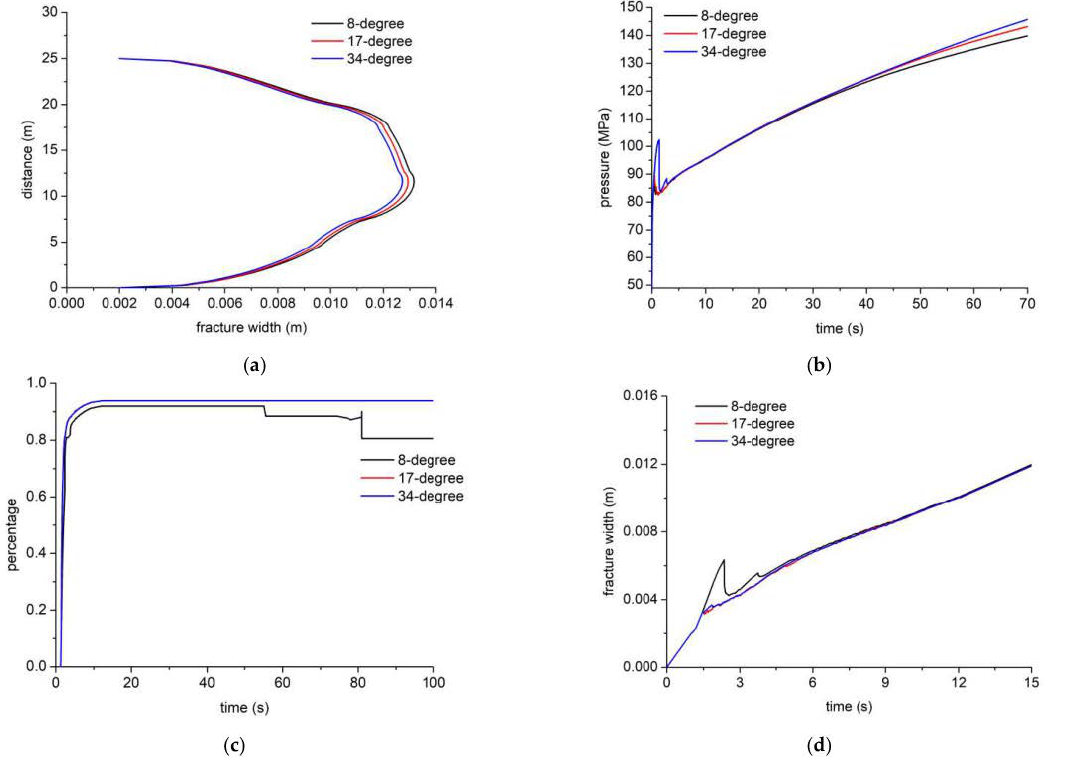
Figure 9. Fracture parameter under different internal frictional angles: ( a ) HF width; ( b ) pressure; ( c ) ratio of tensile failure; and ( d ) maximum HF